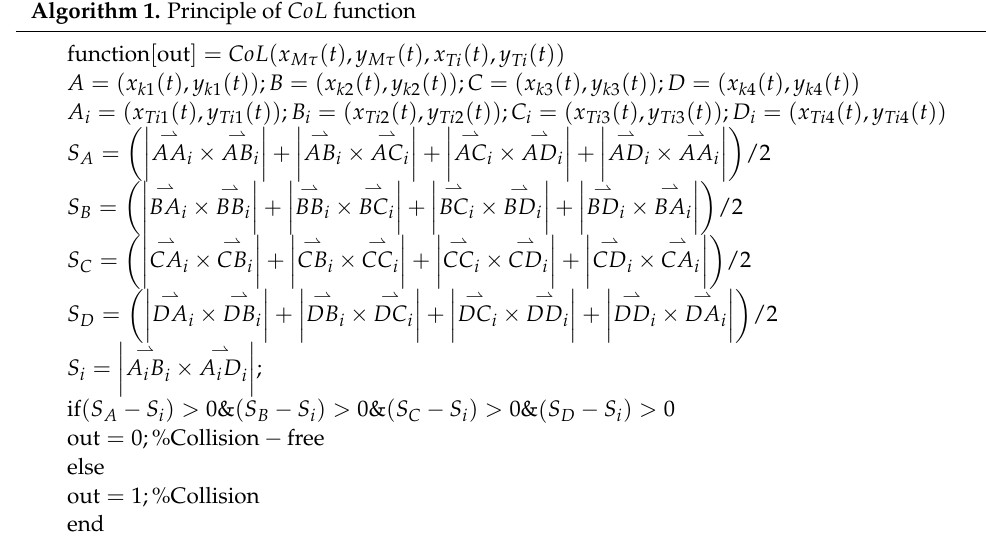
( ) x t ( ) y t The collision between vehicles is approximately the intersection of two rectangles. and are the coordinates of each vertex of the In Formula (17),   1, 4 1, 4 k k τ rectangle, is the end time of the subject vehicle lane change, Hk Algorithm 1. Principle of CoL